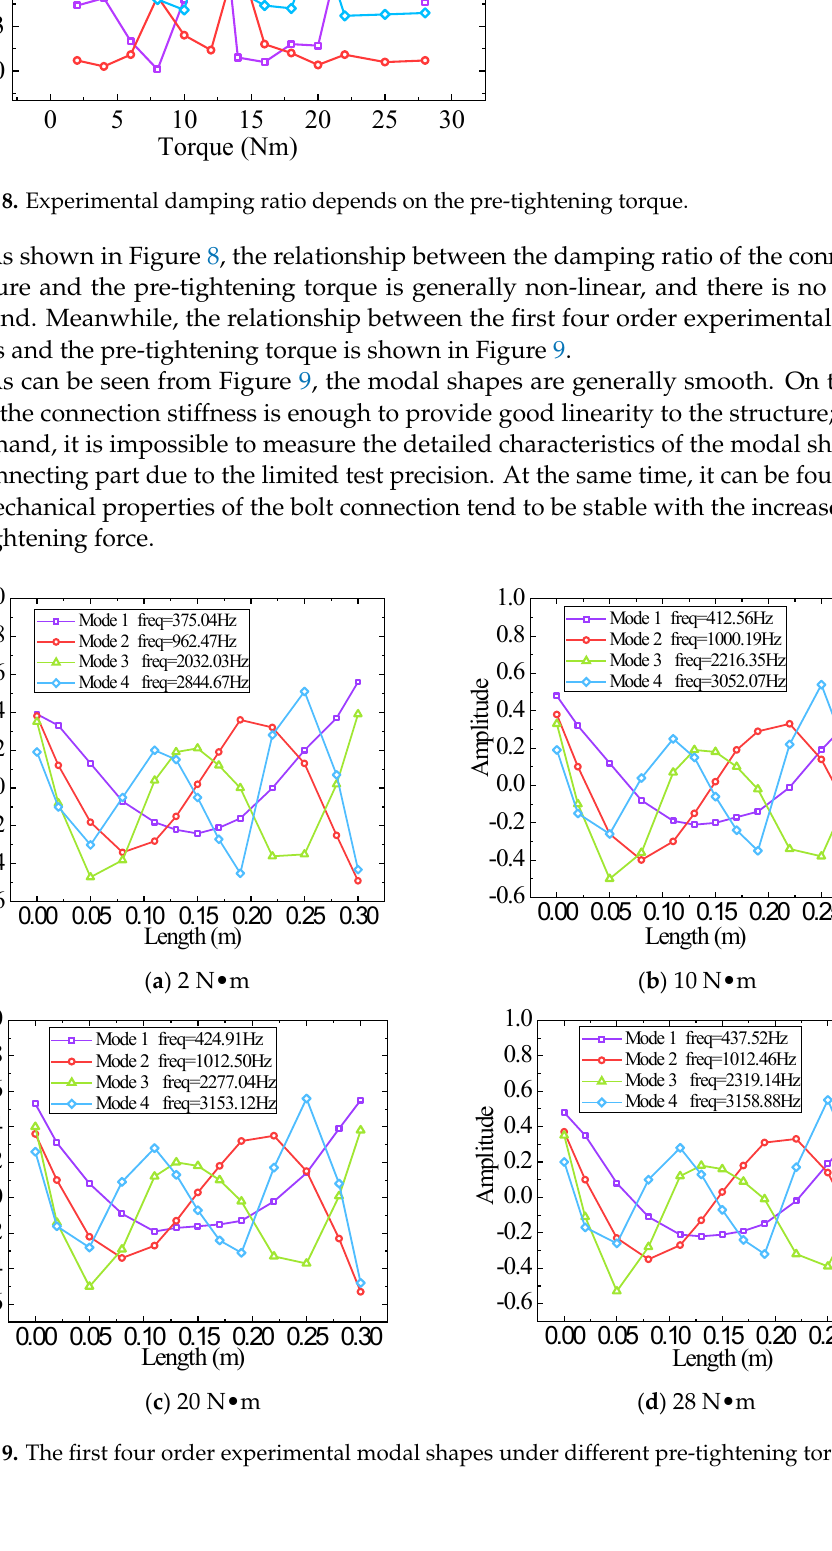
Figure 9. The first four order experimental modal shapes under different pre‐tightening torque.